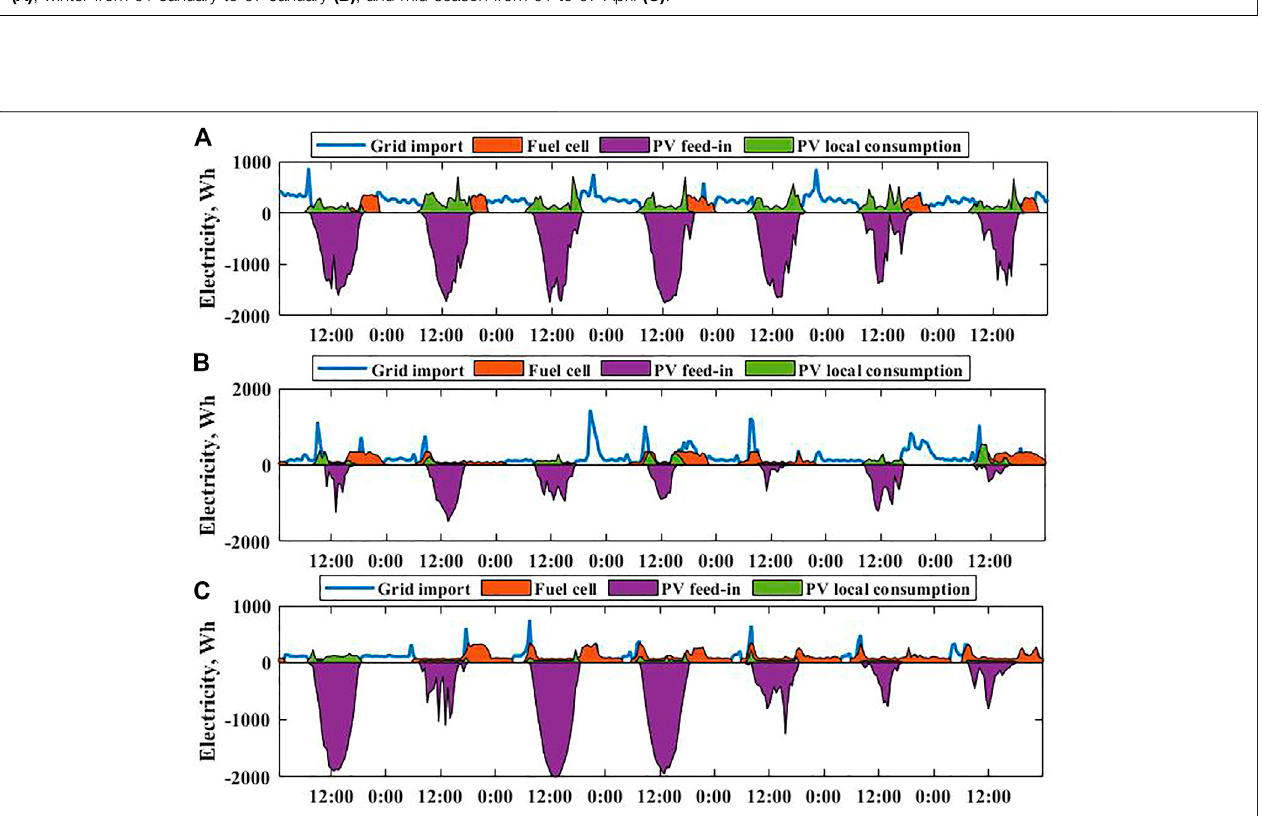
FIGURE 15 | Weekly power fl ows of typical ZEH equipped with PV and fuel cell CHP systems at 30-min intervals in summer 01 August to 07 August (A) , winter 01 January to 07 January (B) , and mid-season 01 to 07 April (C) .